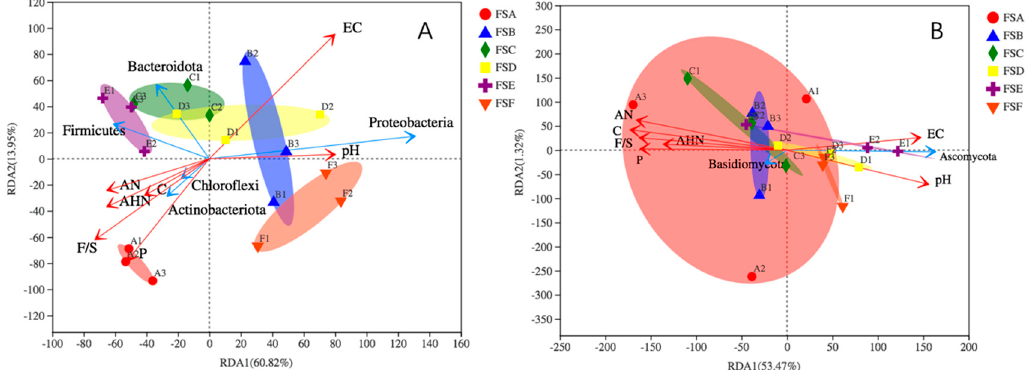
Figure 5. Correlation analysis between dominant microbial communities and environmental factors under different treatments. Note: ( A ) correlation between dominant bacterial phyla and environmental factors; ( B ) correlation between dominant fungal phyla and environmental factors; P − available phosphorus; AHN − alkali-hydrolysable nitrogen; C − organic matter; AN − ammonium nitrogen; EC − electrical conductance; F/S − addition amount of GLR organic fertilizer. The blue arrow shows species. The red arrow indicates environmental factors. The length of the arrow of environmental factors represents the degree of influence of environmental factors on species data. The angle between the arrows represents positive and negative correlation (acute angle − positive correlation; obtuse angle − negative correlation; right angle—no correlation).